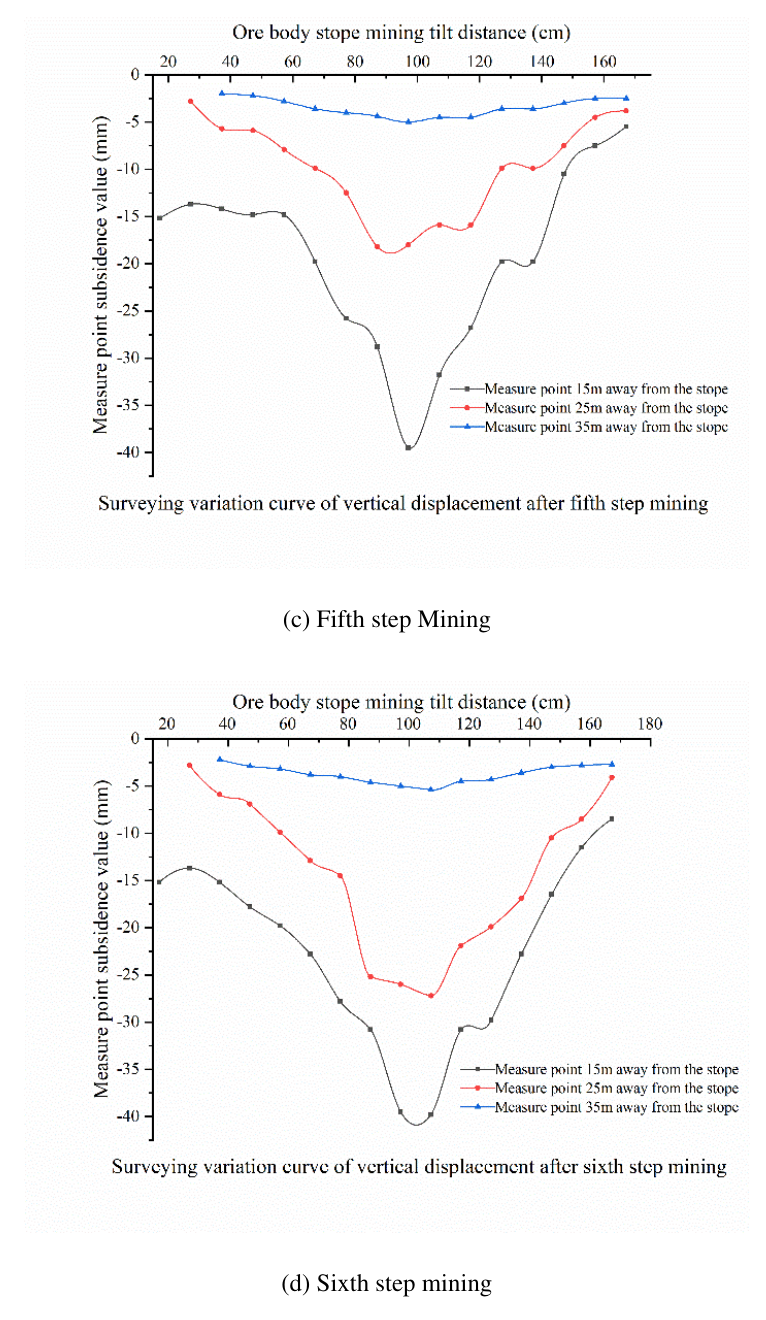
Fig. 3 Subsidence displacements after the first (a), third (b), fifth (c), sixth (d) excavation steps of the similar material